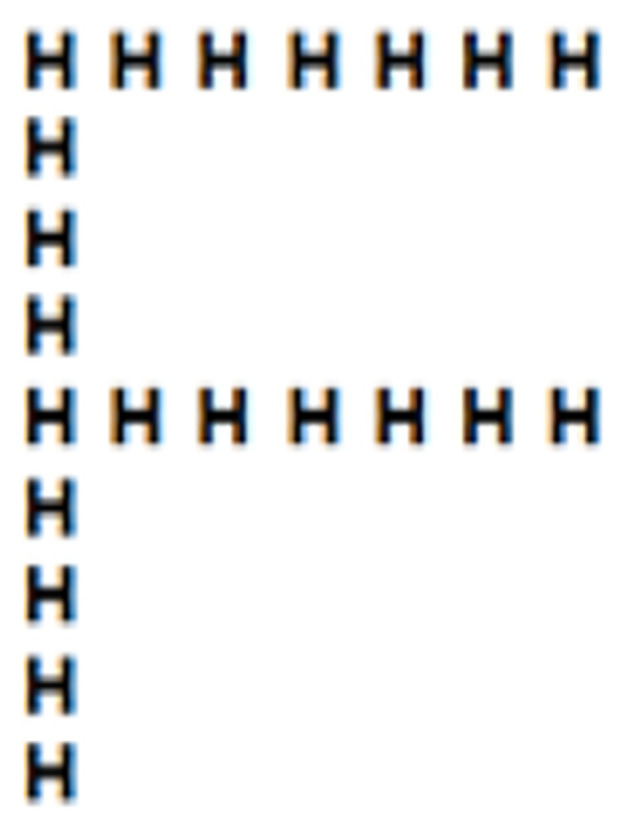
Example of an incongruent Navon letter stimulus (e.g., Navon, 1977).